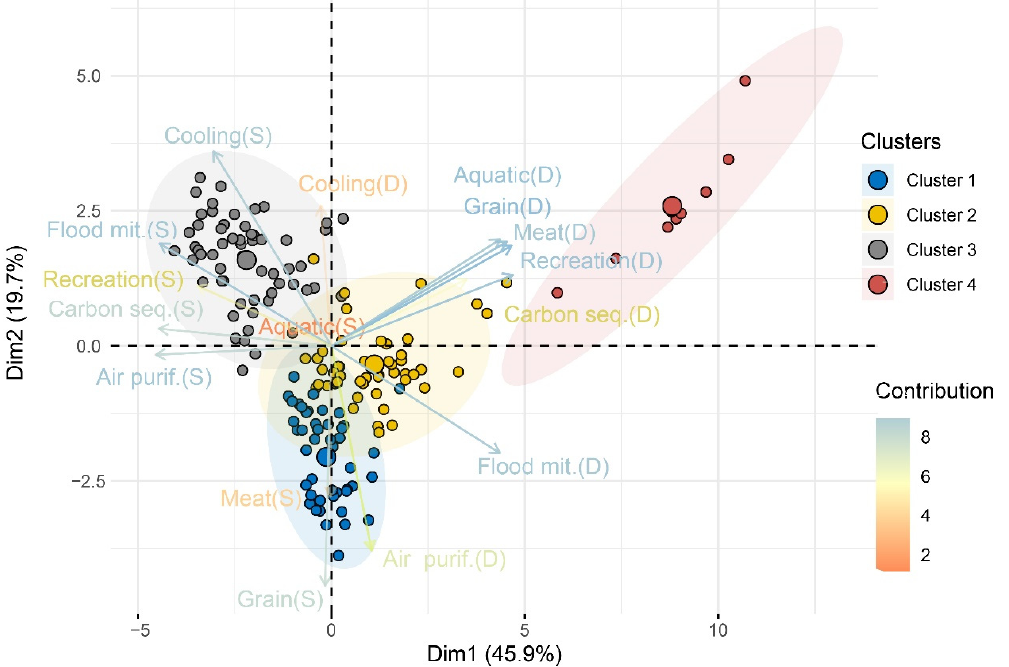
Figure 9. Principal component analysis results for the ES supply and demand indicators within each cluster.